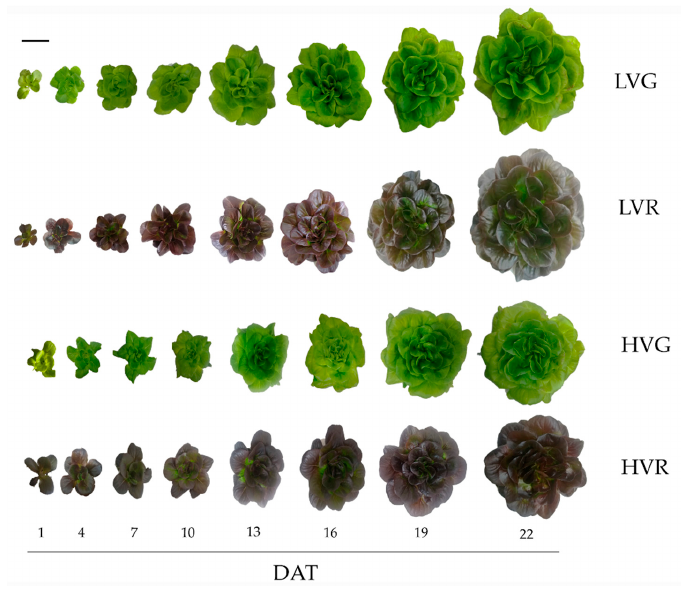
Figure 1. The phenotype of a representative green (G) and red (R) plant from low (LV) and high (HV) VPD condition during the growth cycle. The bar on the top left refers to 10 cm.